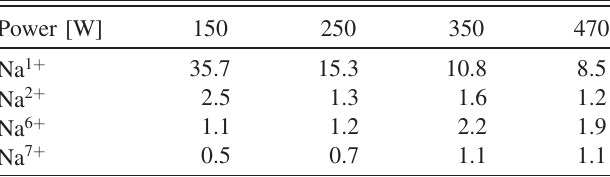
TABLE III. Mean-free paths (upper limit) and ion-ion collision frequencies (lower limit) for different charge states of Na ions in helium